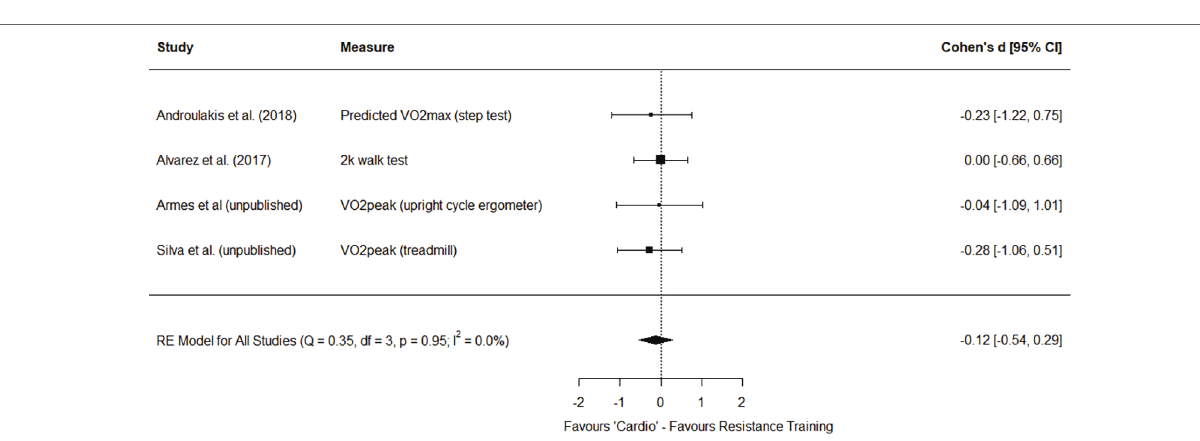
FIGURE 3 | Forest plot for random effects (RE) meta-analysis of cardiorespiratory fitness outcomes from studies using effort matched designs to compare “cardio” and resistance training modalities.